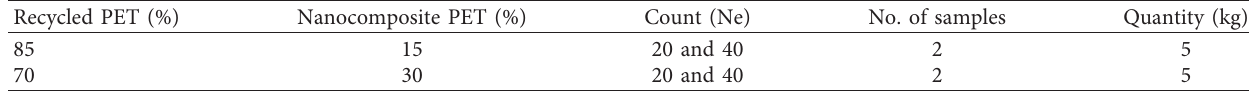
Figure 1: (a) Two blends of R-PET and SNC-PET (85:15 and 70 :30). (b) Blended yarn. Table 2: Number of samples with recycled polyester and silver nanocomposite polyester blend